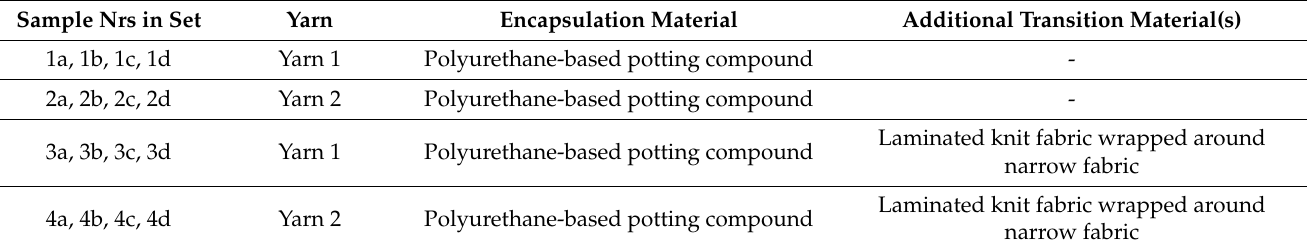
Figure 2. Testing set-up with the motor at the top left side and where the 180-degree rotation also takes place. ( a ) Machine set-up highlighting where the 180-degree bending takes place, where the PCB is placed on the woven ribbon and then encapsulated in the black potting compound, the soft–rigid transition area and the connection between the ADC and sample. ( b ) Close-up photo of the soft–rigid transition area (from the potting compound to the white narrow fabric) also highlighting the conductive yarns woven into the white narrow fabric (in red). ( c ) Close-up photo of the connection between the ADC and the sample. ( d ) Technical drawing of the sample set-up for the bending test: light-grey part represents narrow fabric, red lines represent conductive yarns woven into the ribbon, black part represents the encapsulation/potting and green parts represent the ADC connection to the ribbon. Table 2. Sample sets’